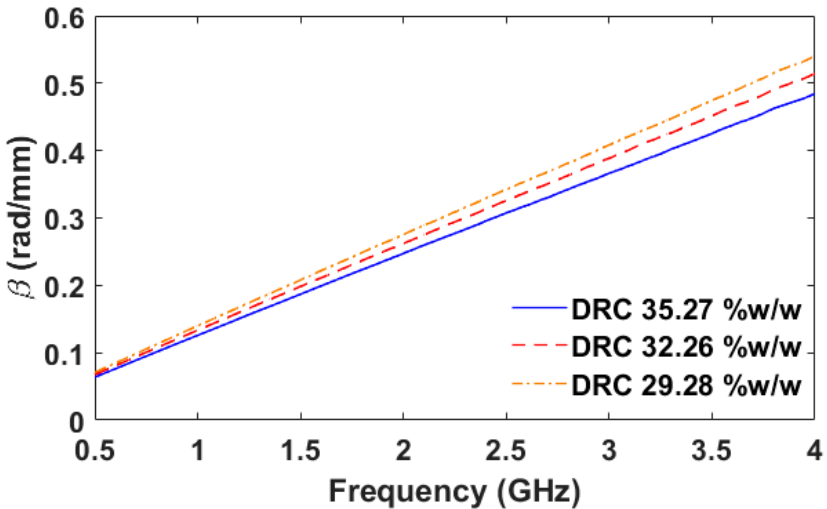
Figure 22. Phase constant of natural latex samples with different DRCs over the frequency range of 0.5–4.0 GHz at the temperature of 25 °C.